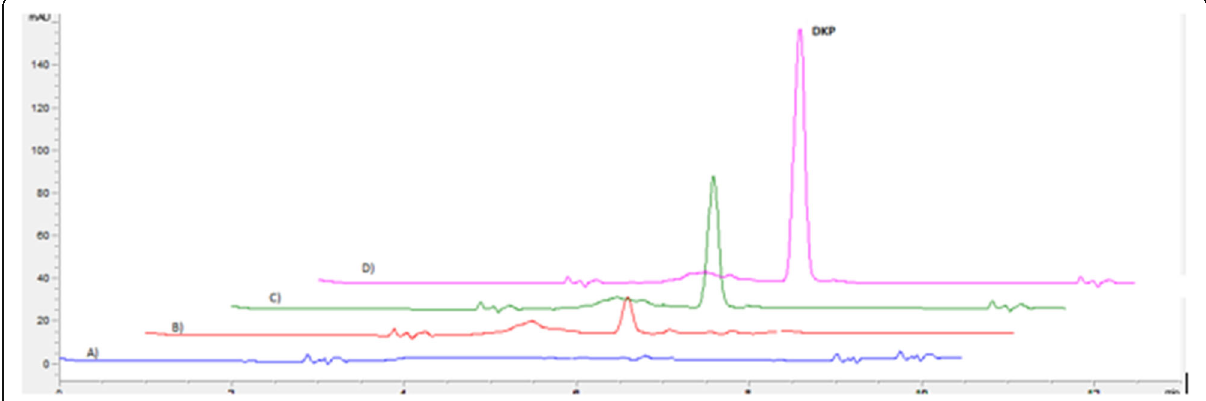
Fig. 8 The chromatographic analysis of plasma samples: A was the chromatogram of blank plasma sample; B, C, and D were the chromatogram of plasma samples that contains 0.25, 0.5, and 1.0 μ g mL − 1 DKP